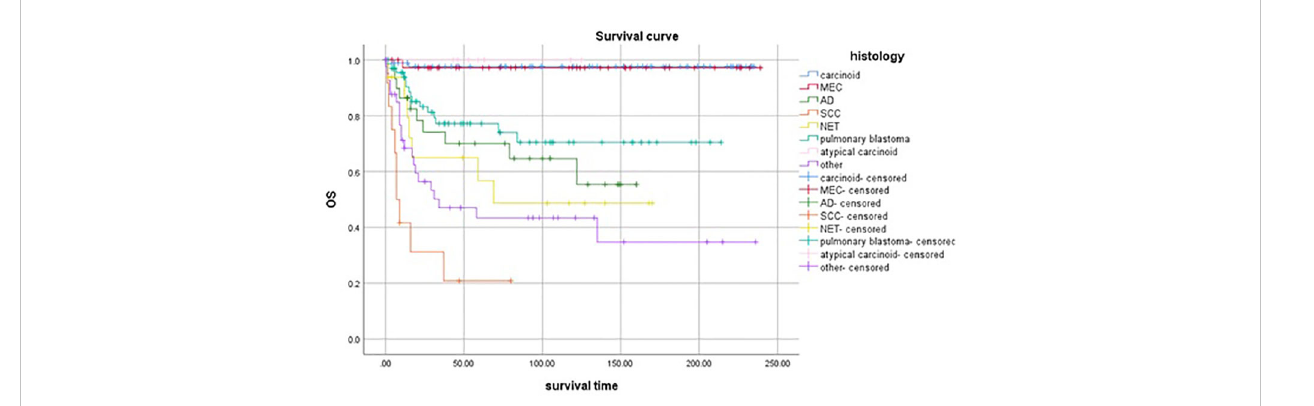
FIGURE 3 Survival curve of patients with different histological tumor